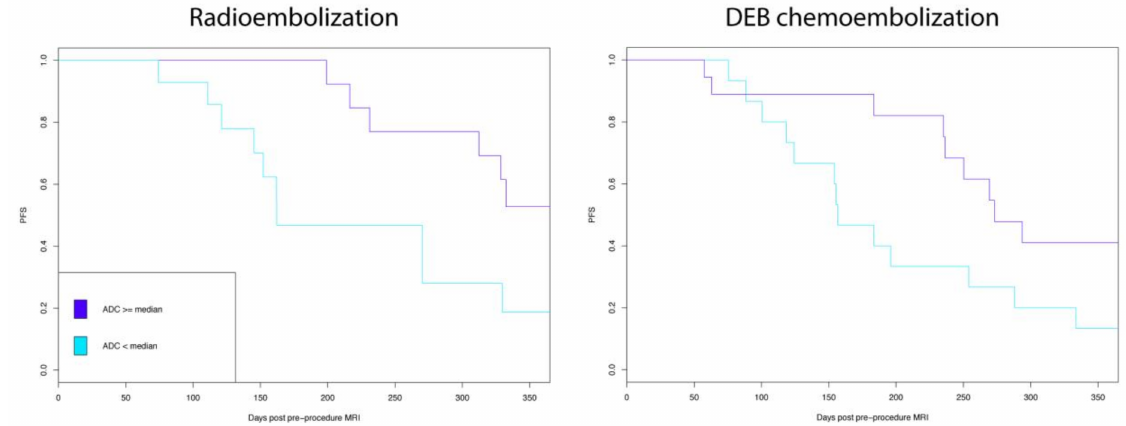
Figure 2. Low apparent diffusion coefficient (ADC) values were significantly associated with poorer index lesion specific progression free survival (PFS) for both radio embolization and drug eluting embolic (DEE) chemoembolization.